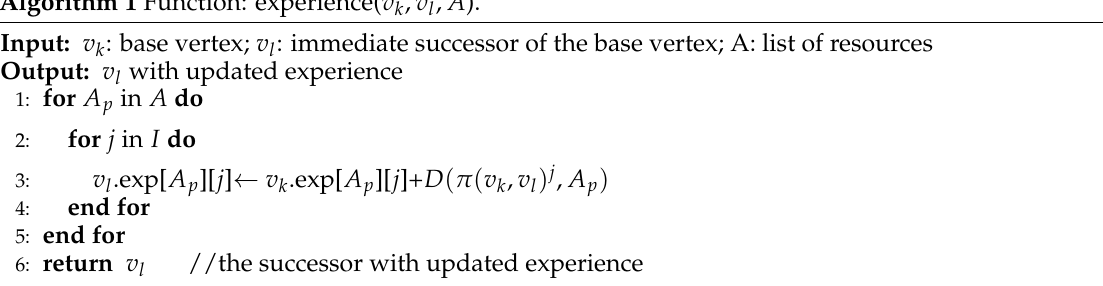
Algorithm 1 Function: experience( v k , v l , A